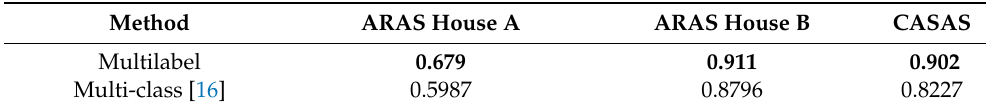
Table 13. F1 score comparison between multilabel and multi-class classification approaches. Best values are in